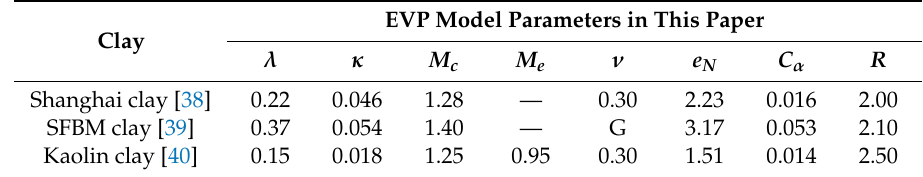
Table 2. Elasto-viscoplastic (EVP) model parameters for di ff erent clays. EVP Model Parameters in This Clay